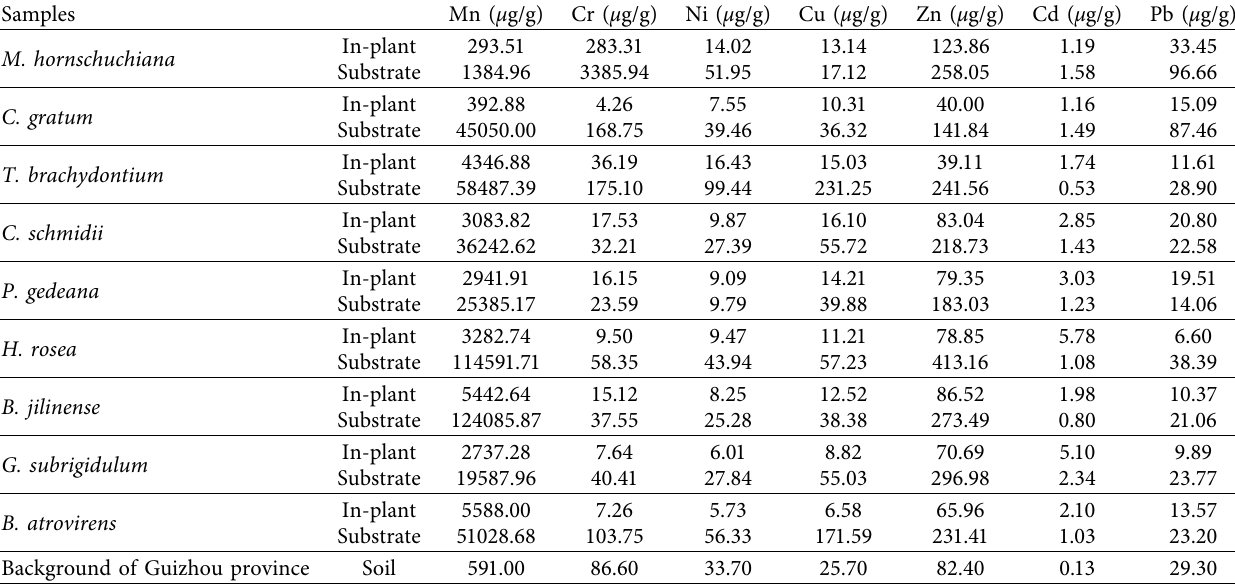
Table 5: Content of heavy metals in bryophytes and growth substrate from mine waste